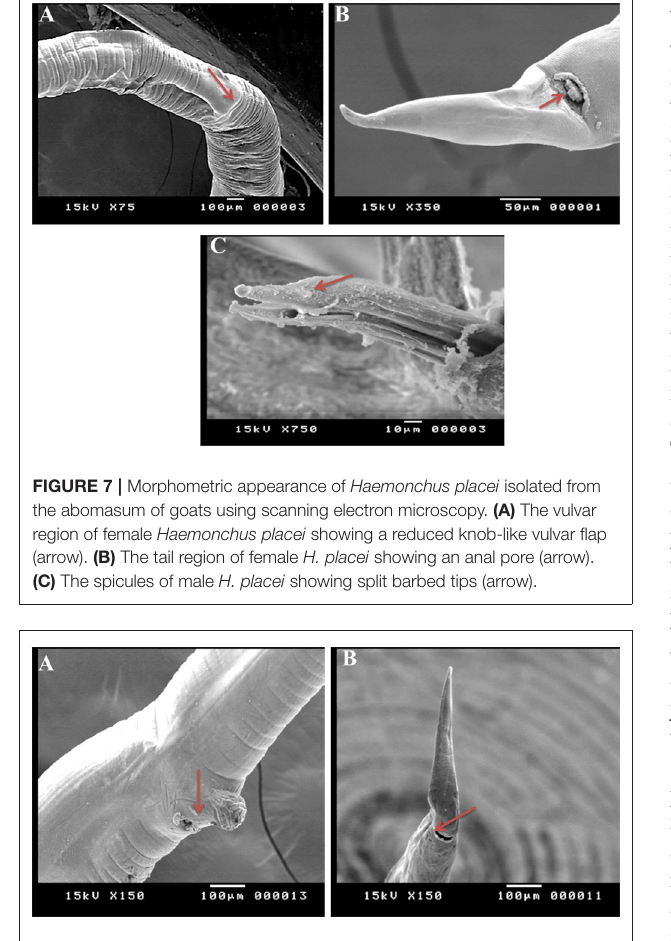
FIGURE 8 | Morphometric appearance of Haemonchus longistipes isolated from the abomasum of goats using scanning electron microscopy. (A) The vulvar region of female Haemonchus longistipes showing a small rough nut-like vulvar flap (arrow). (B) The tail region of female H. longistipes showing an anal pore